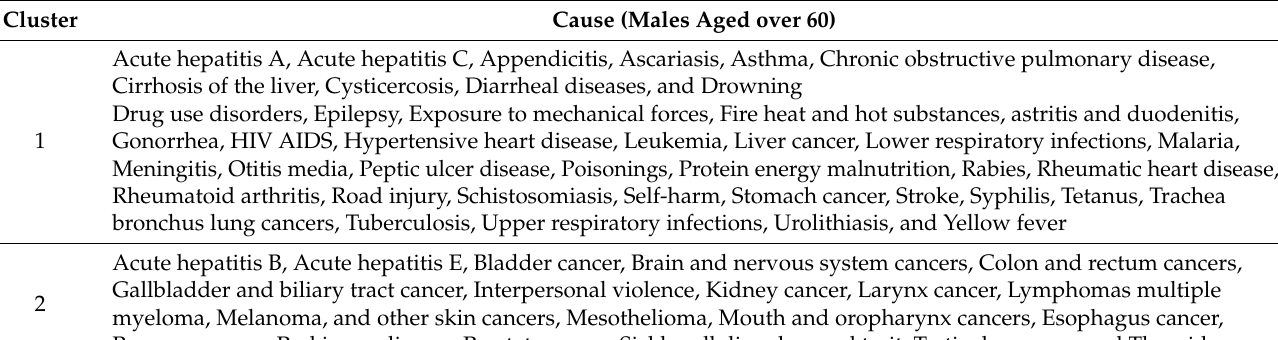
Table A2. Cluster members for males aged over